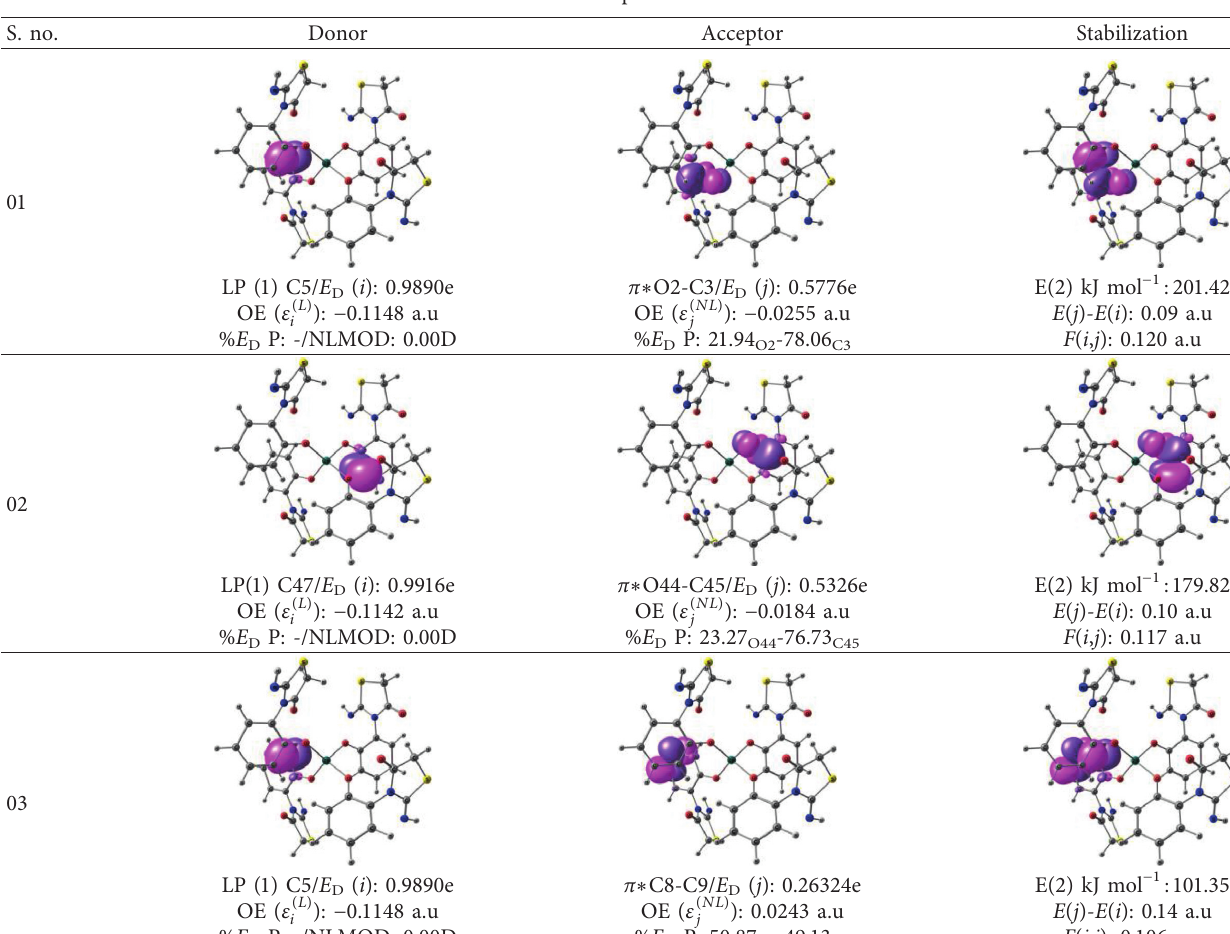
Table 7: NBO profile of